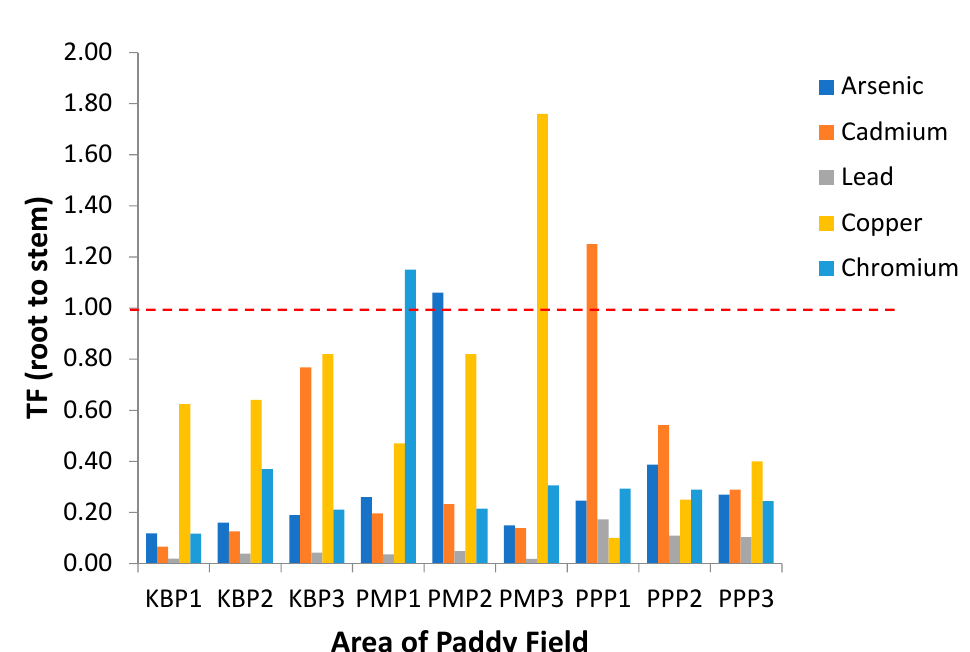
PMP3: Pasir Mas Plot 3, PPP1: Pasir Puteh Plot 1, PPP2: Pasir Puteh Plot 2, and PPP3: Pasir Puteh Plot 3.